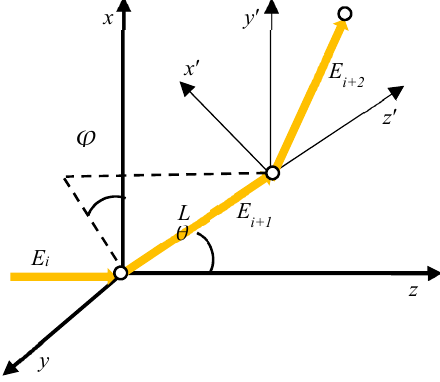
Figure 4. Schematic of a Monte Carlo simulation.